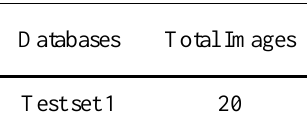
Table 1. Data sets.